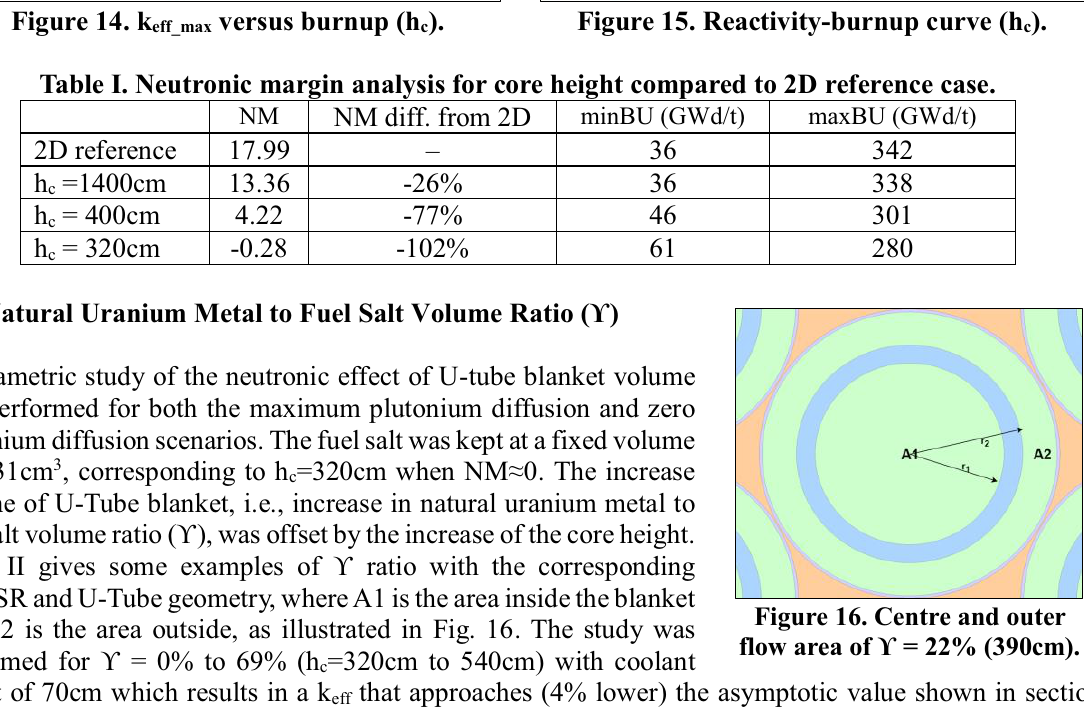
Figure 14. k versus burnup (h eff_max